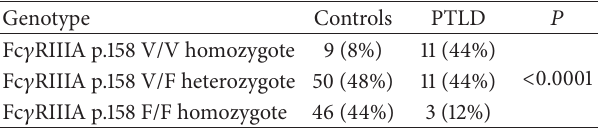
Table 2: Frequency of Fc 𝛾 RIIIA p.V158F genotypes and alleles in healthy controls and PTLD